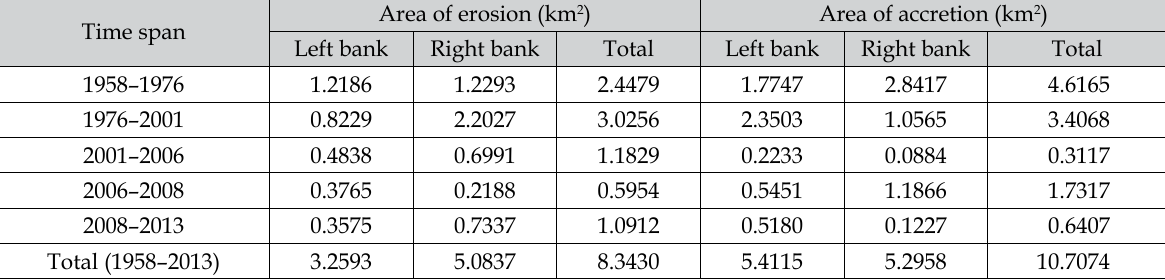
Table 1. Area of riverbank erosion and accretion of the Bosna River from 1958 to 2013. area of erosion (km 2 Time span